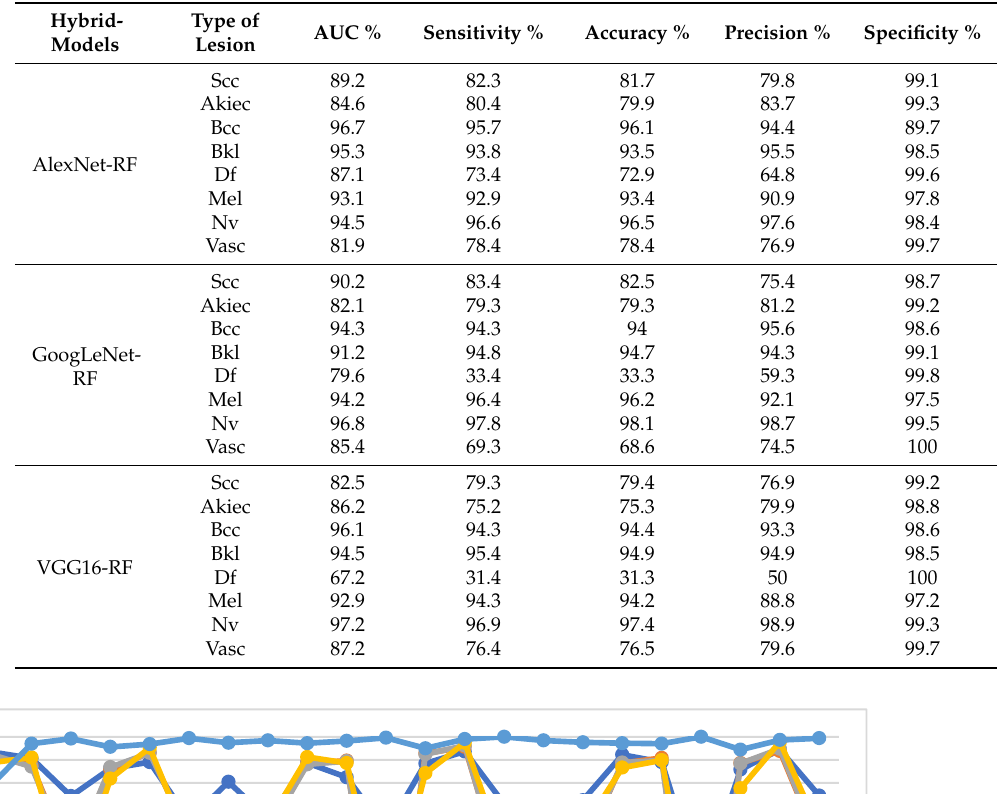
Table 6. Performance results of CNN-RF hybrid models based on ROI using the GAC method for early diagnosis and differentiation of skin cancer and other skin lesions.